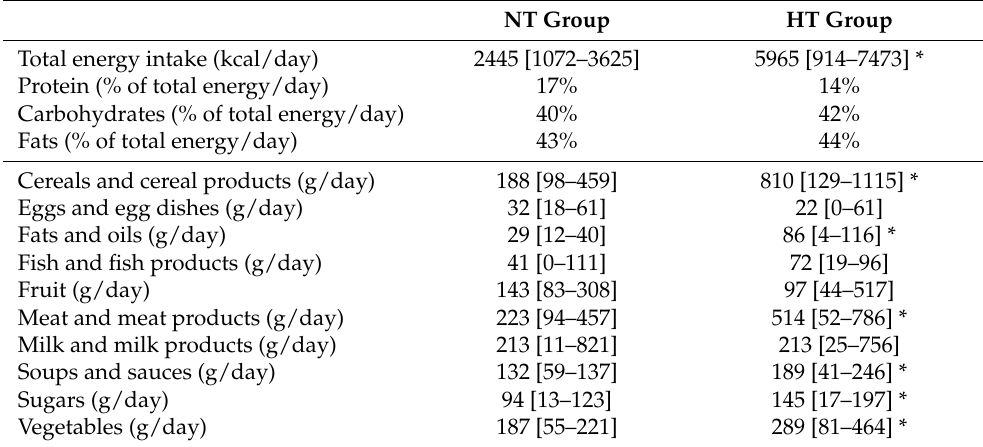
Table 4. Daily dietary intake assessed by EPIC-Norfolk Food Frequency Questionnaire